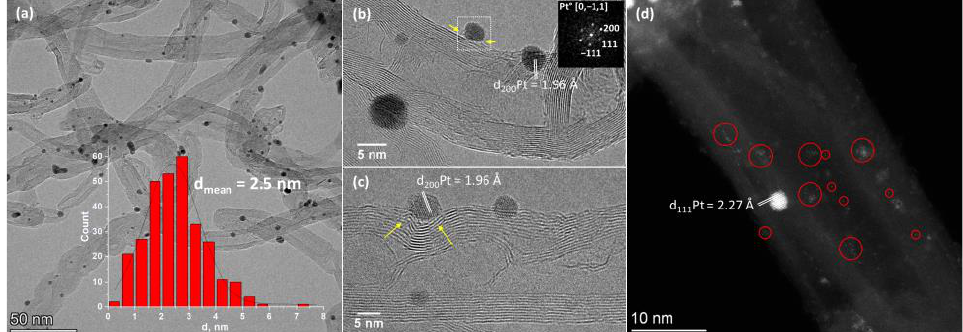
Figure 1. TEM data for the Pt-C catalyst: ( a ) TEM image. The Pt particle size distribution is shown in the inset. ( b – c ) HRTEM images with an indication of the interplanar distances, corresponding to metallic platinum. The FFT pattern of the region marked by the square is shown in the inset (panel b ). ( d ) HAADF-STEM image. Red circular marks indicate single Pt atoms and Pt clusters on the MWCNT